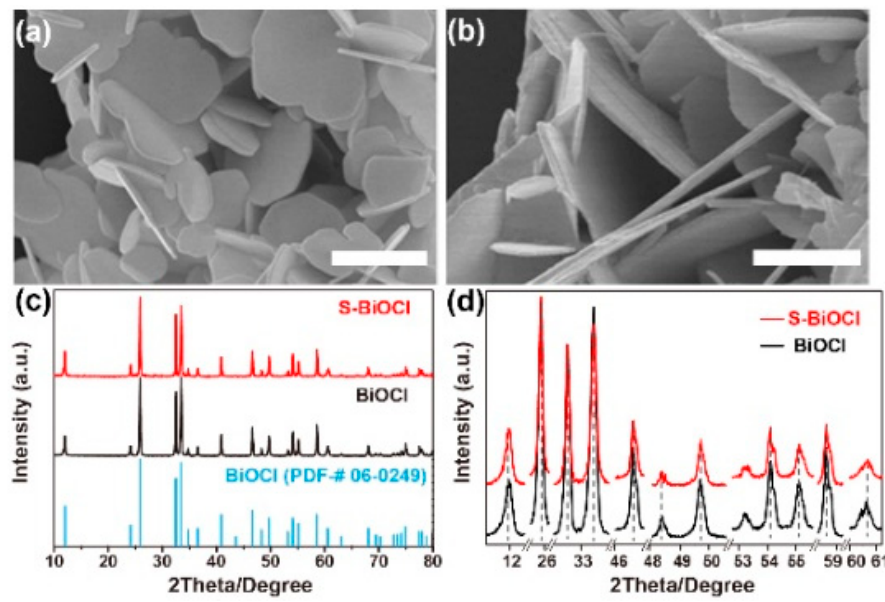
Figure 1. SEM images of ( a ) commercial BiOCl and ( b ) S-BiOCl. Scale bar: 1 μ m. ( c ) XRD patterns and ( d ) partial amplified XRD patterns of commercial BiOCl and S-BiOCl.